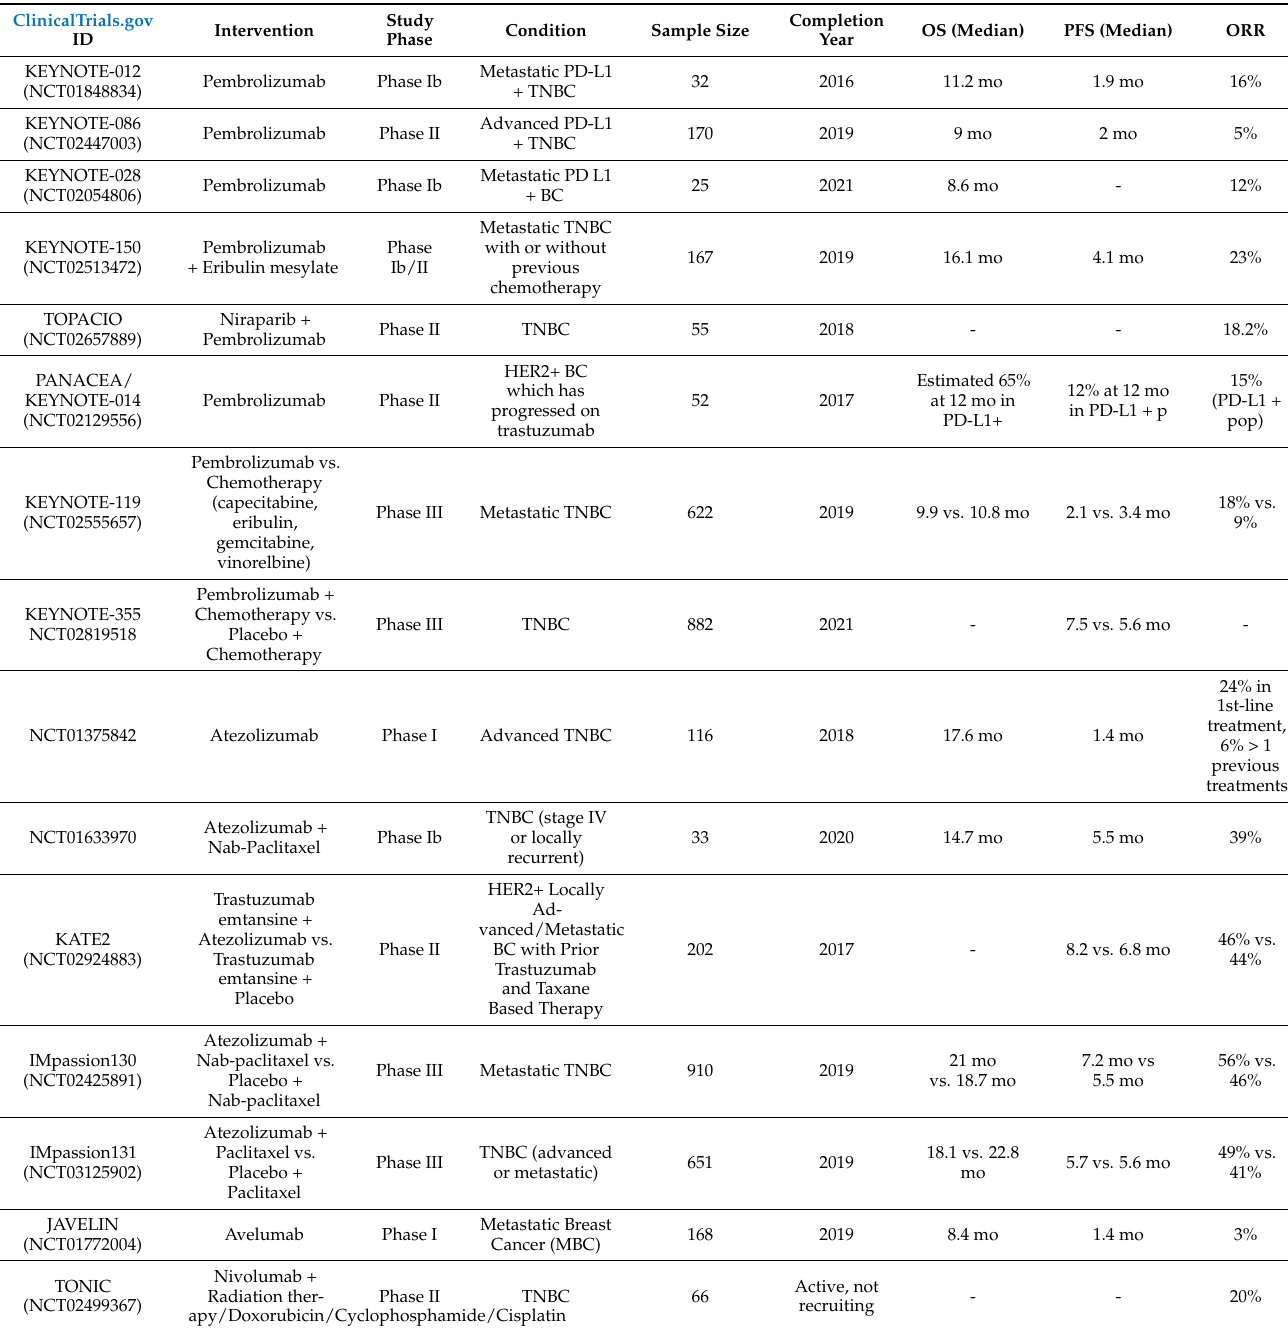
Table 3. Important Clinical Trials of Checkpoint Inhibitors in Breast Cancer